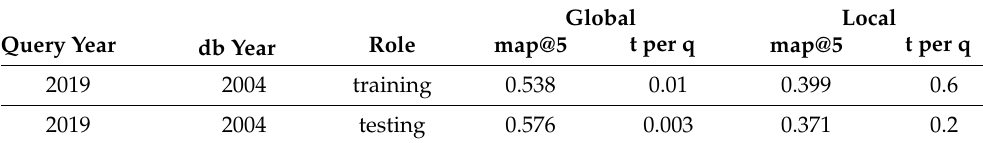
Table 8. The map@5 results for the global and local descriptors, cross-department